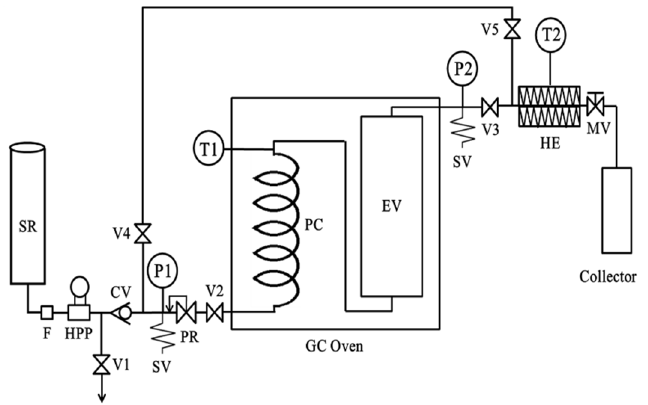
Figure 1. Semicontinuous subcritical water extraction system (CV, check valve; EV, extraction vessel; F, filter; HE, heat exchanger; HPP, high-pressure pump; MV, metering valve; p , pressure gauge; PC, preheating coil; PR, pressure regulator; SV, safety valve; SR, solvent reservoir; T, temperature indicator; V, on/off valve).